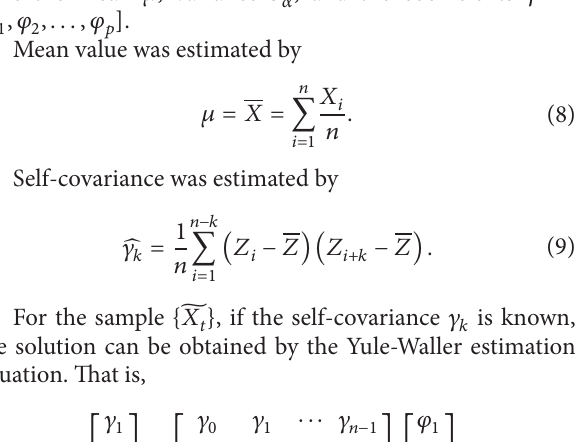
Figure 6. In the figure, S1 ∼ S10 are eddy current